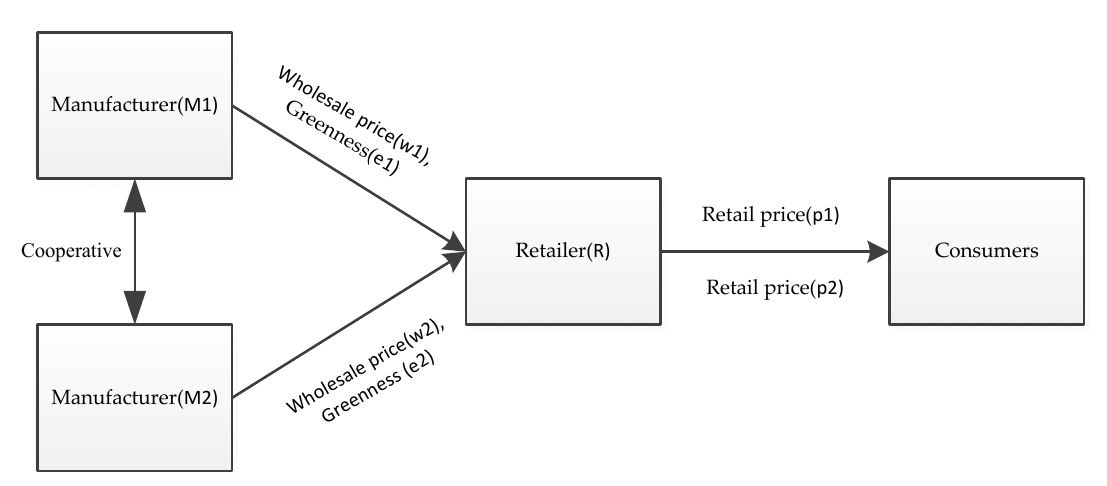
Figure 1. Manufacturers-cooperative three-stage supply chain.